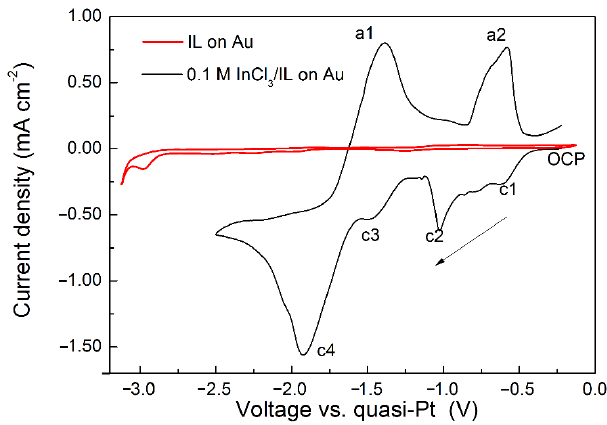
Figure 1. Cyclic voltammogram (CV) of 0.1 mol/L InCl 3 in [Py 1,4 ]TFSI (black) and of pure [Py 1,4 ]TFSI (red) on an Au electrode in the glove-box between the open-circuit potential (OCP, − 0.2 V) and − 2.5 V vs. quasi-Pt reference. Scan rate of 10 mV s − 1 .